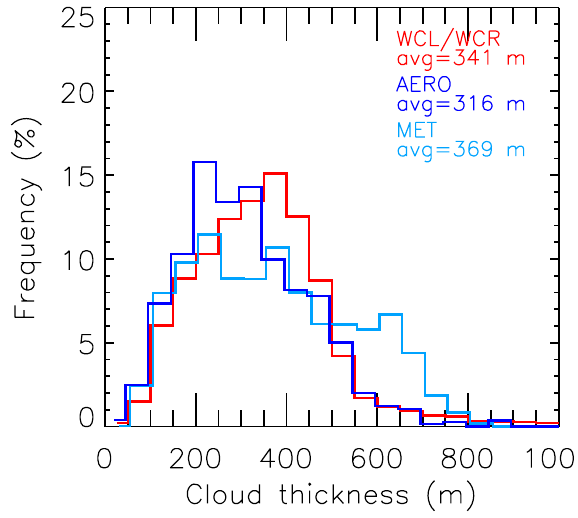
Fig. 9. Histogram of cloud thickness from the Wyoming cloud lidar (WCL) and radar (WCR) observations (red), and from the AERO (blue) and MET (light blue)